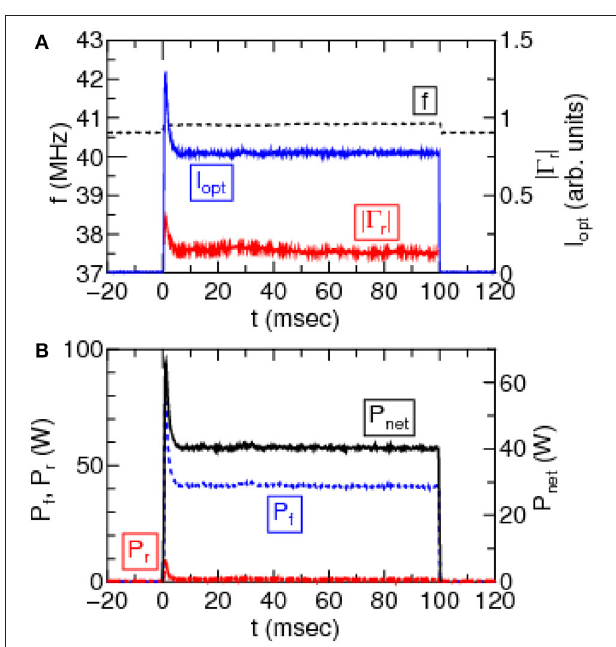
FIGURE 8 | (A,B) The same data set as in Figures 7A,B for f 0 and P set =